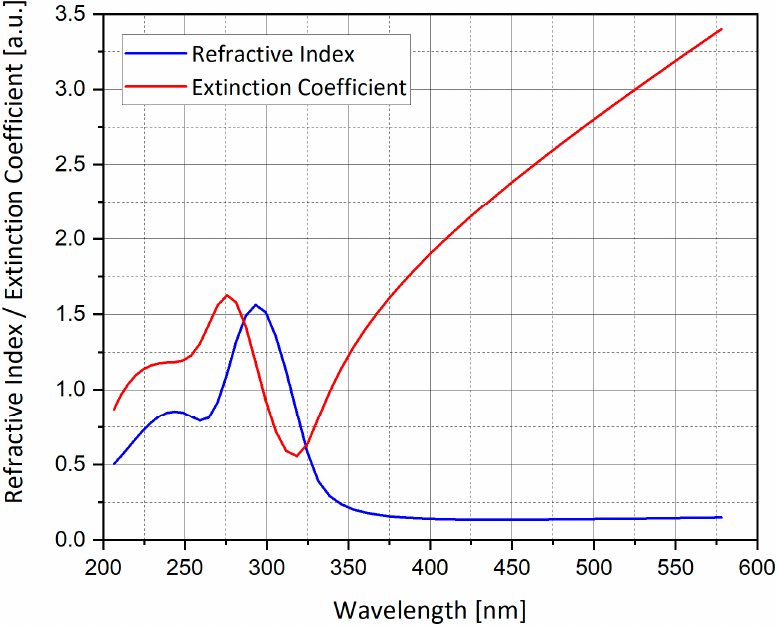
Figure 1. Refractive index and extinction coefficient of silver (Ag).